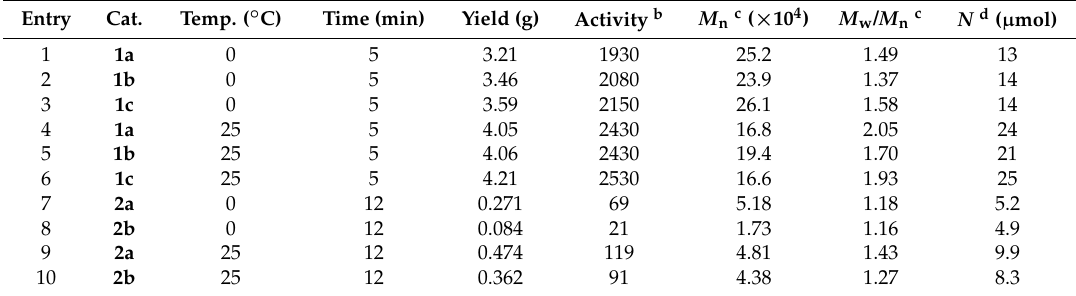
Table 3. Propylene polymerization with Ti complexes 1a – 2b activated by MMAO a .